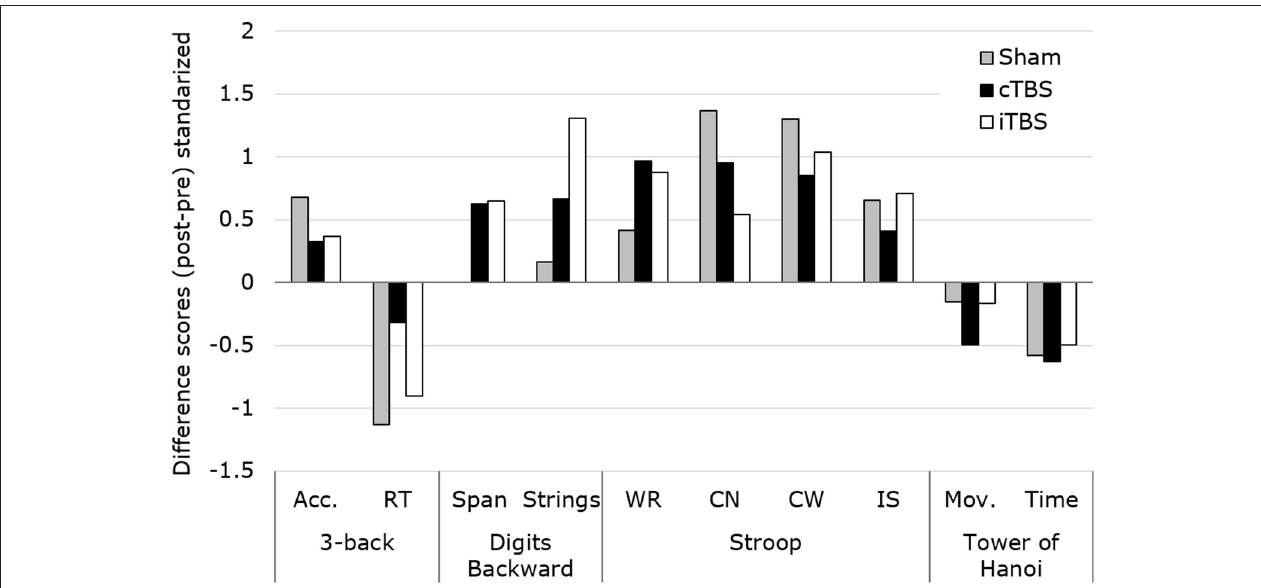
FIGURE 4 | Representation of the standardized changes for each of the evaluated scores (mean/SD), across groups and tasks. The Kruskal–Wallis H -test revealed no statistically significant modulations of TBS patterns between conditions for any of the outcome measures. Acc., Accuracy; RT, reaction time; WR, Word Reading; CN, Color Naming; CW, Color-Word; IS, Interference Score; Mov., Number of